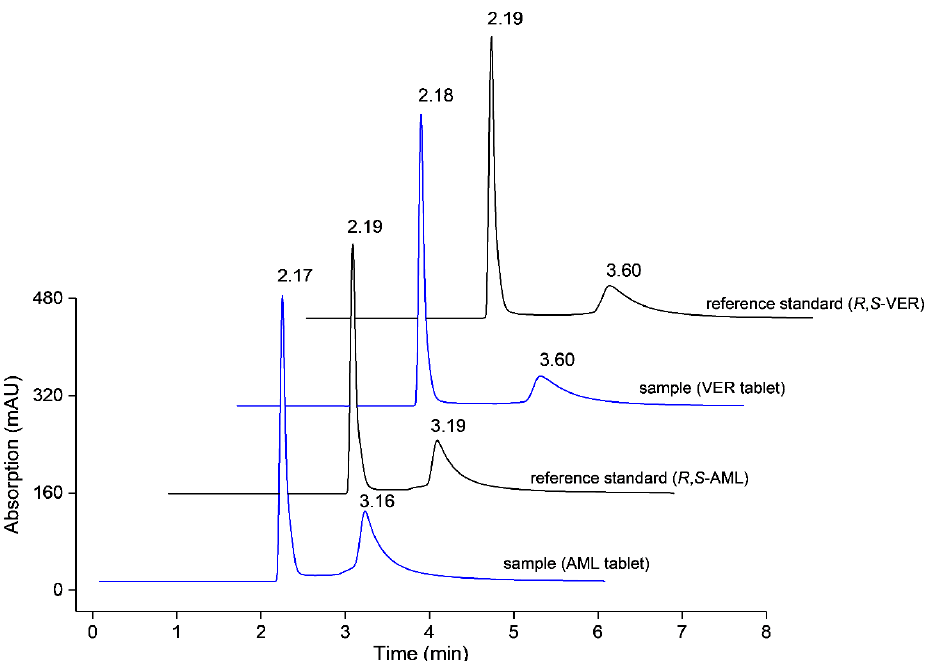
Figure 3. Determination of active pharmaceutical ingredients in commercial tablet matrices. The chromatograms represent amlodipine (AML) 80 µg/mL and verapamil (VER) 100 µg/mL with their individual reference standards at the corresponding concentrations.